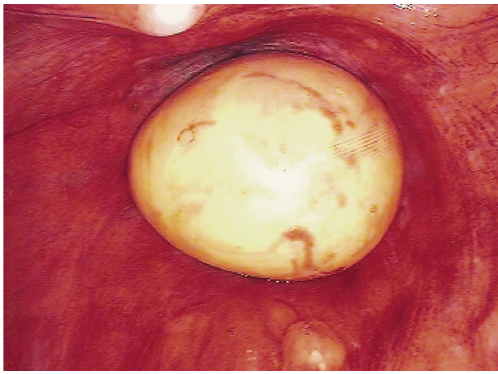
Figure 2: A cream-coloured ovoid mass is seen anterior to the rectum with the tip of the urethral catheter visible anterior to